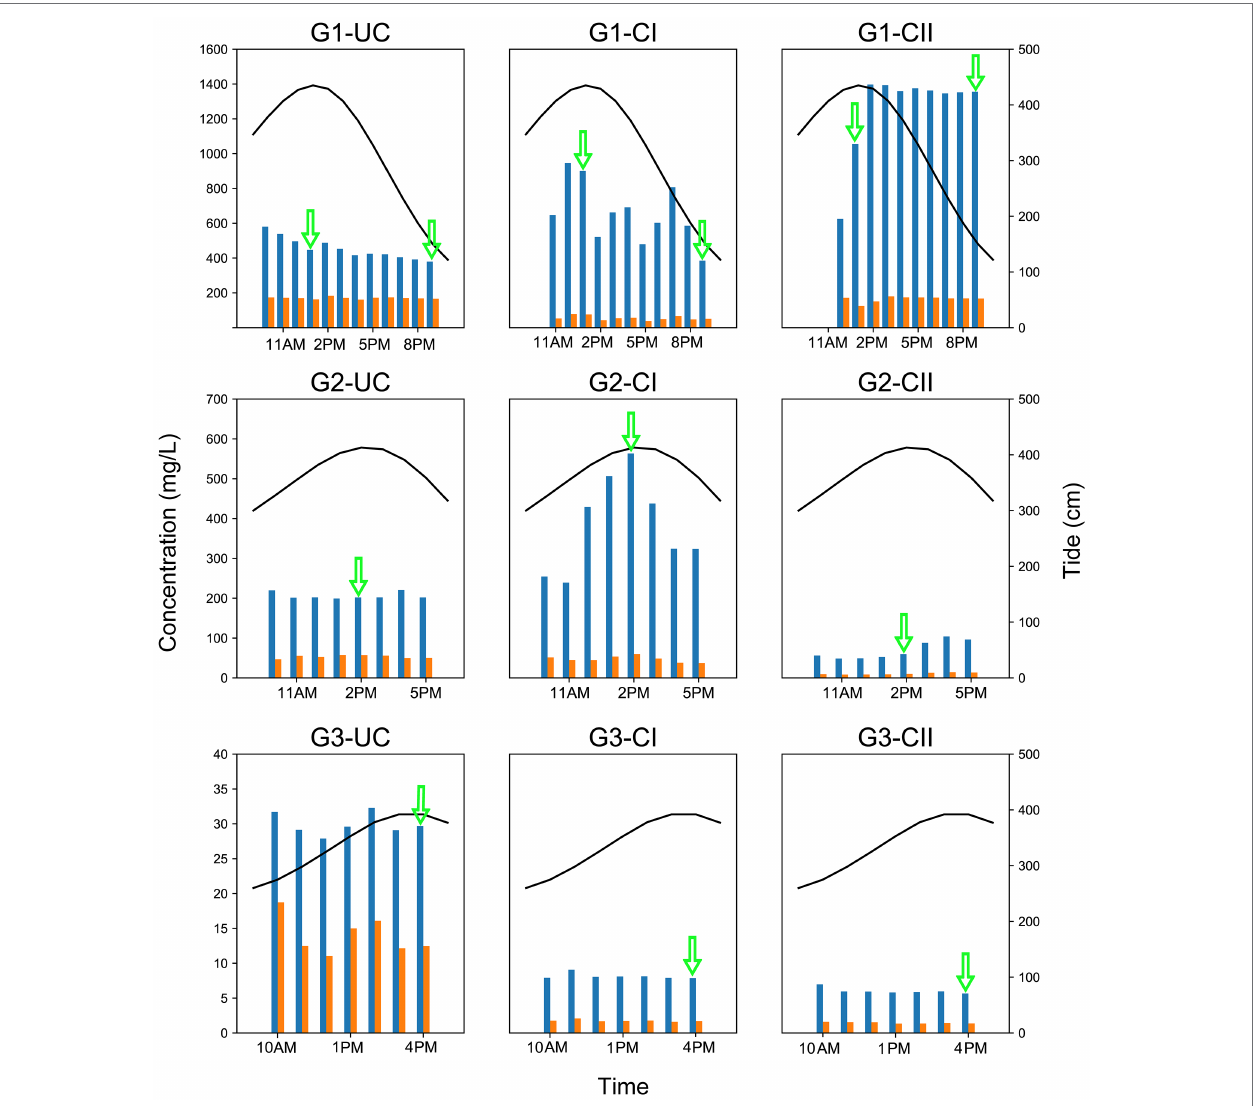
FIGURE 2 | Variation of the Cl − and SO 42 − concentrations and tide level in different underground aquifers of the three monitoring sites. Blue bars in the plot represent the Cl − concentration and the orange bars represent the SO 42 − concentration. The black solid line above each graph indicates the tidal level of the Beihai Port of Beihai City. The green arrow indicates when microbial sampling was performed. The left y-axis represents the concentrations of Cl − and SO 42 − , the right y-axis represents the tidal level, and the x-axis represents time. The tidal data in the figure was obtained from the China oceanic information network (http://www. nmdis.org.cn). G1, G2 and G3 indicate monitoring site. UC, unconfined aquifer; CI, confined aquifer I; CII, confined aquifer